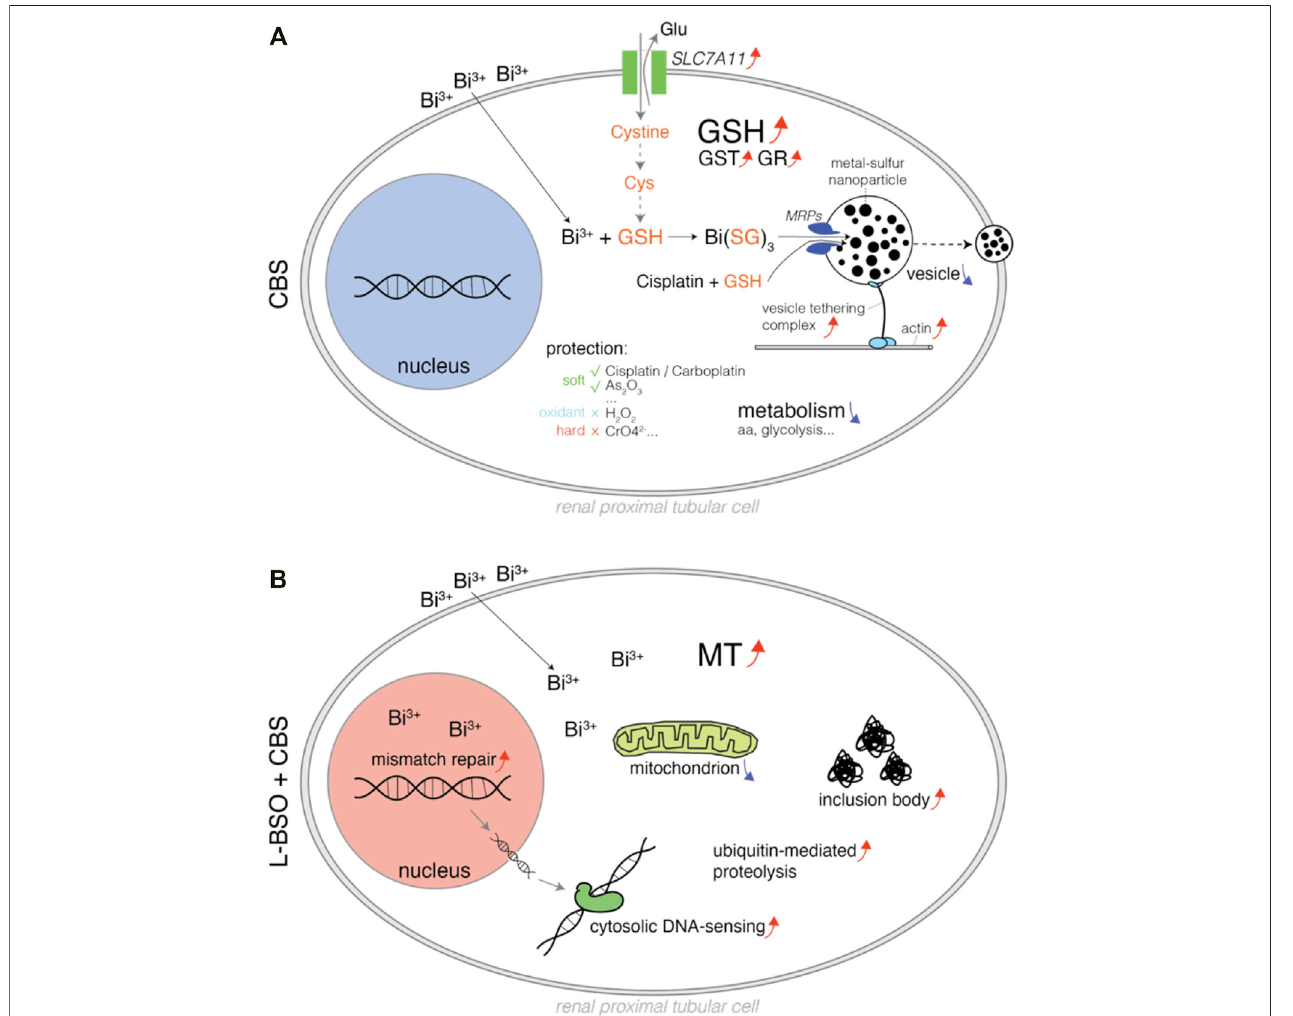
FIGURE 7 | Schematic diagram illustrating the pharmacological, metabolic, and proteomic alterations in bismuth-treated proximal tubular cells. (A) HK-2 cells treatedwithCBS,andthebismuthionswereconjugatedtoGSHandtransportedtothevesicles,whichcanbeexportedbyactinandthevesicle-tetheringcomplex.The mechanism also sequesters cisplatin and likely other soft metal – based compounds. CBS downregulated the metabolism of amino acids and glycolysisbut upregulated cystineimporterSlc7a11. (B) GSH-depletedHK-2cellstreatedwithCBS,andtheMTlevelwasincreased.CBSdamagedintracellularproteinandDNA,causingan increase of inclusion body, ubiquitin-mediated proteolysis, mismatch repair, and cytosolic DNA sensing mechanism. CBS also affects the mitochondrial respirasome.